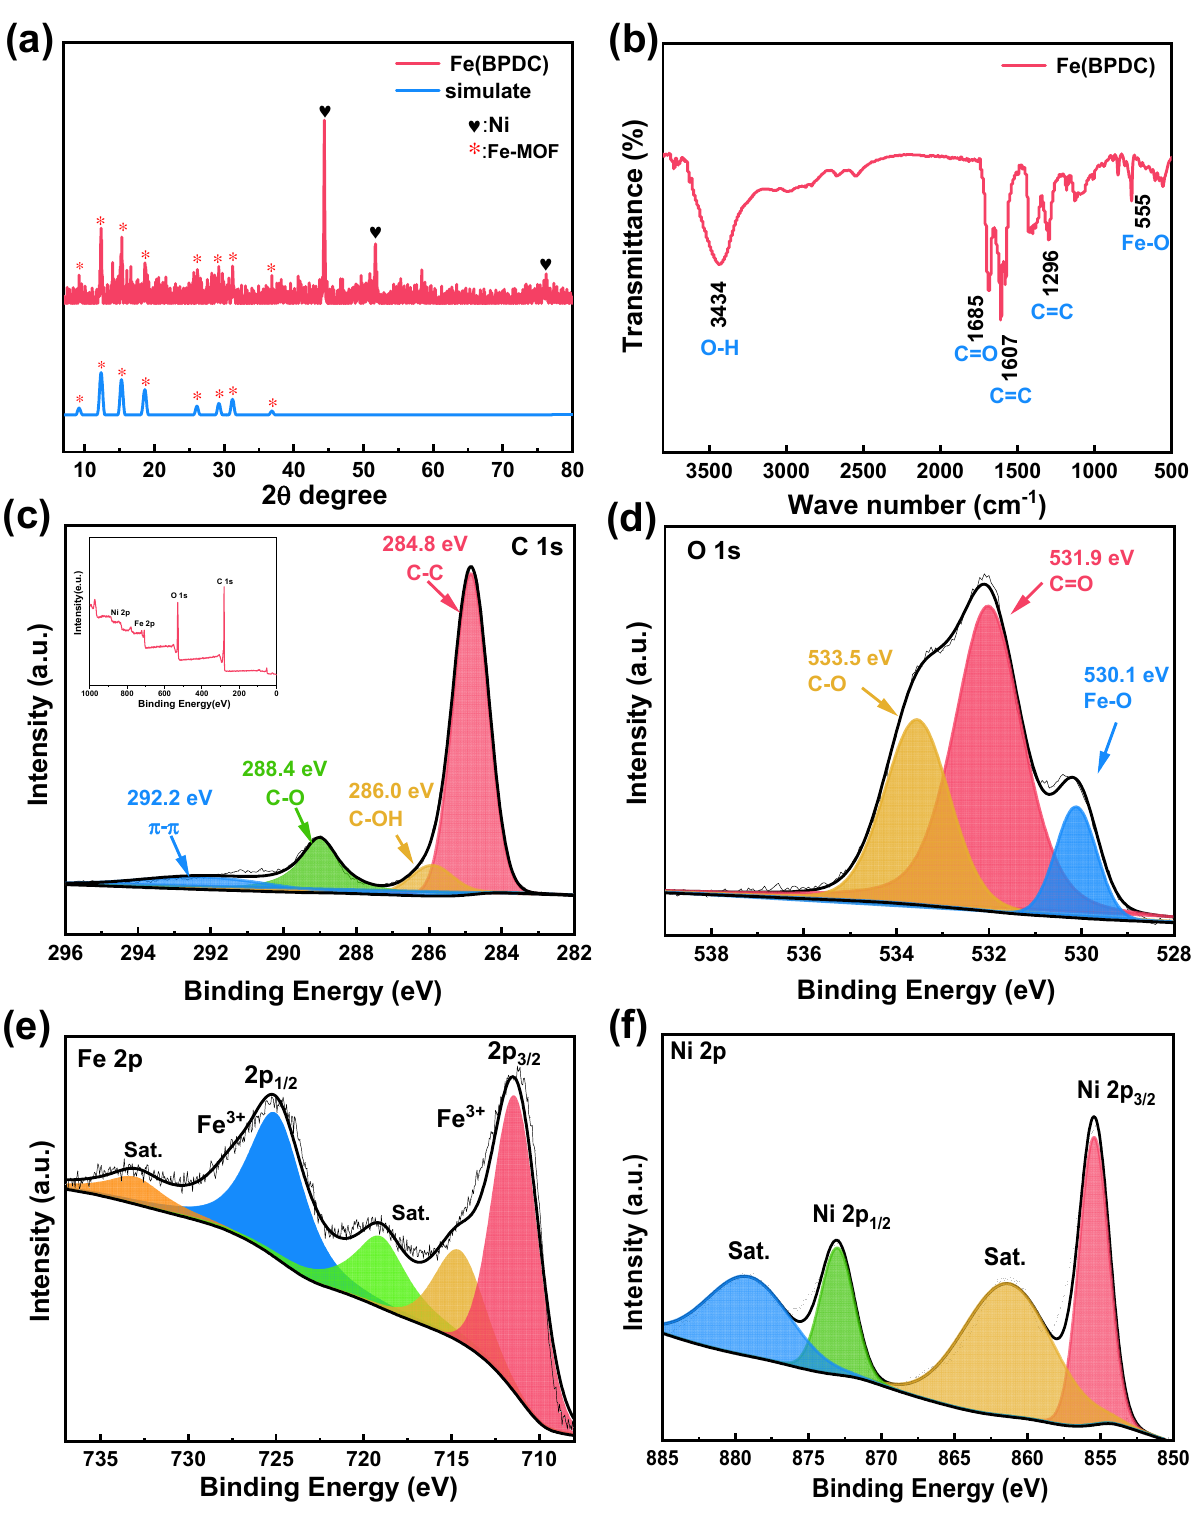
Figure 3. Characterization. ( a ) XRD patterns of Fe(BPDC)–3. ( b ) FT–IR spectra of Fe(BPDC)–3. High–resolution XPS spectra of ( c ) C 1 s, ( d ) O 1 s, ( e ) Fe 2p, ( f ) Ni 2p of Fe(BPDC)–3, respectively. (Inset in ( c ) is the XPS total spectrum).